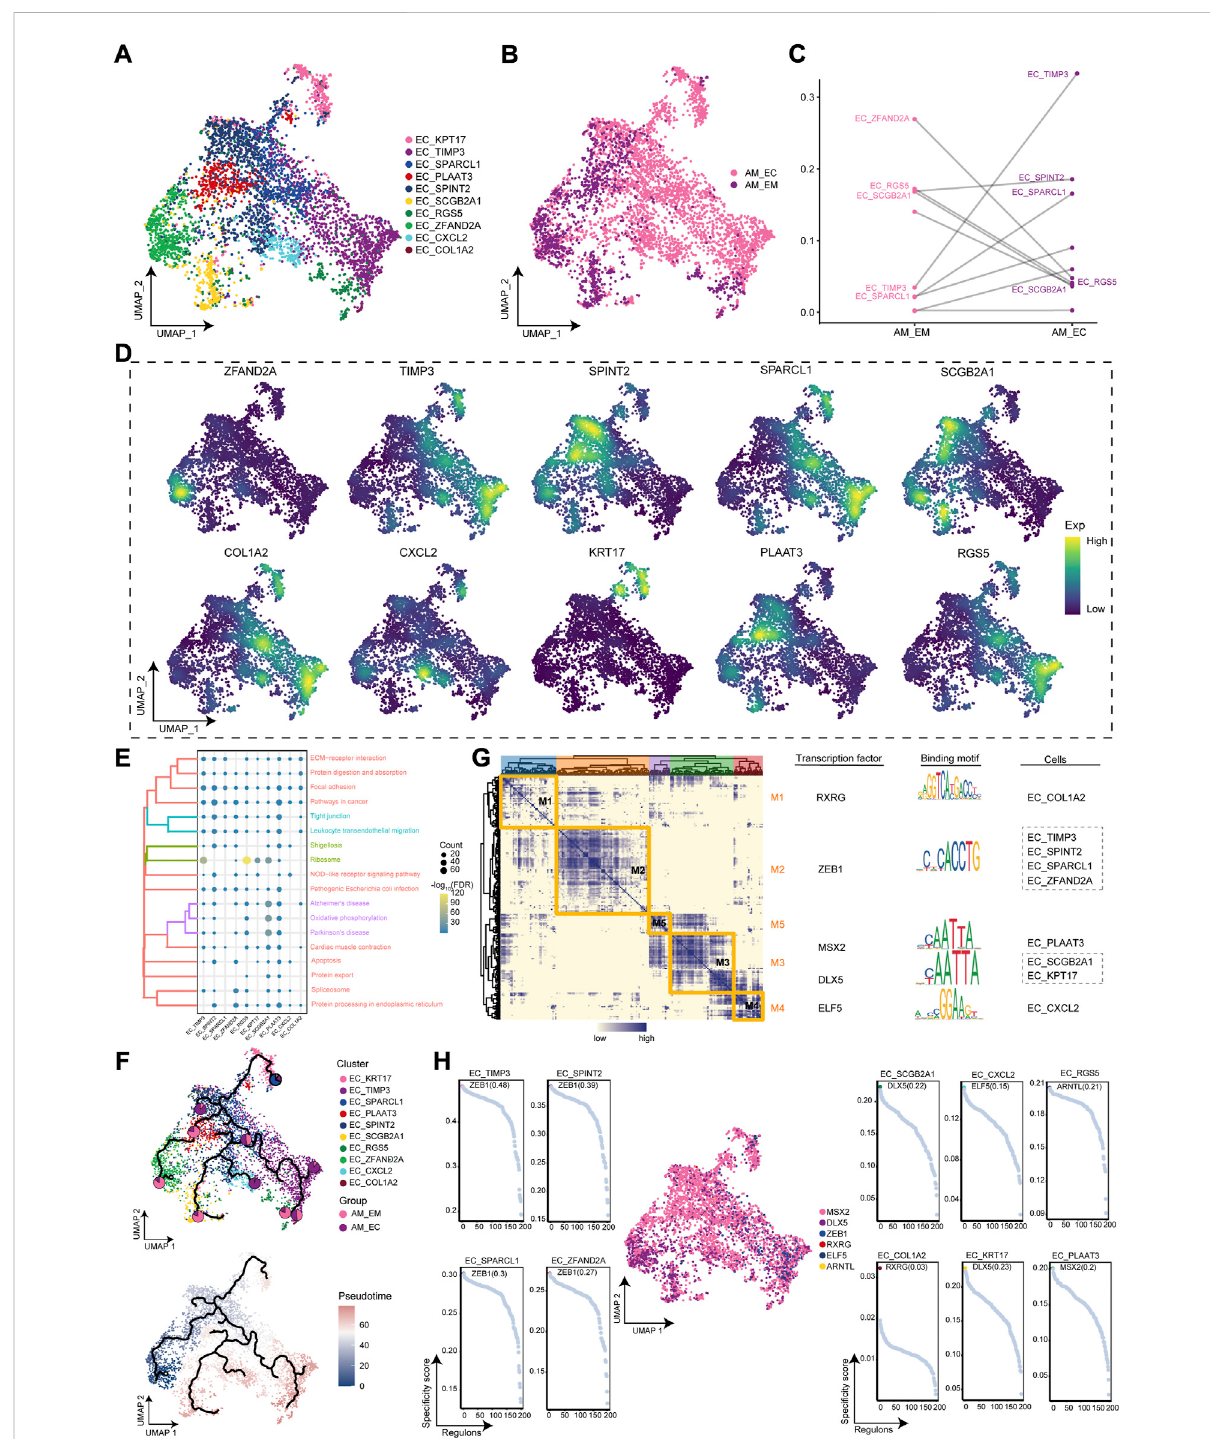
FIGURE 2 Identi fi cation of the endometrial cells (EC) clusters in adenomyosis (AM). (A) . Single-cell atlas shows the cellular clusters of EC. (B). Single-cell atlasshows clusters ofEC cellsin eutopicendometrium andectopicendometrialsamples fromAM patients. (C) . Differences intheabundanceofEC clusters in the eutopic and ectopic endometrium groups of AM patients. (D). Marker genes for the speci fi c EC clusters. (E). Biological pathways in speci fi c clusters of EC. (F). Single-cell atlas map the trajectory and pseudotime values of EC progression. Pie charts show the proportion of the different groups in the clusters. (G). Heatmap-TF-binding sequence-cell clusters demonstrate the gene regulatory network of EC clusters. (H). Transcription factors regulate the makers of EC clusters. AM_EM, eutopic endometrium; AM_EC, ectopic endometrium; EC, endometrial cells; UMAP, Uniform Manifold Approximation and